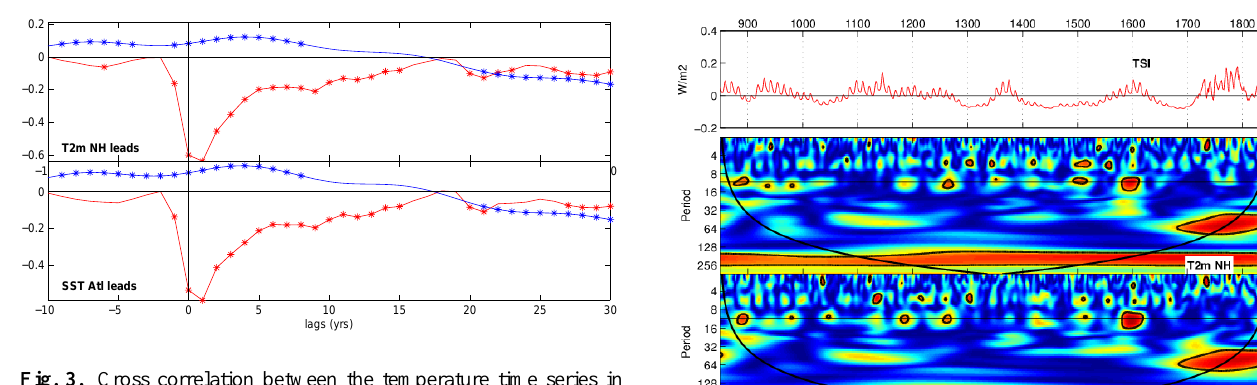
Fig. 3. Cross correlation between the temperature time series in Fig. 2 and the time series of the solar forcing (blue) and the vol- canic forcing (red) from 850 to 1850 A.D. Lags with a star are sig- nificant at the 5% level, tested against a bootstrap procedure with 500 permutation of the forcing time series using blocks of 3 years.